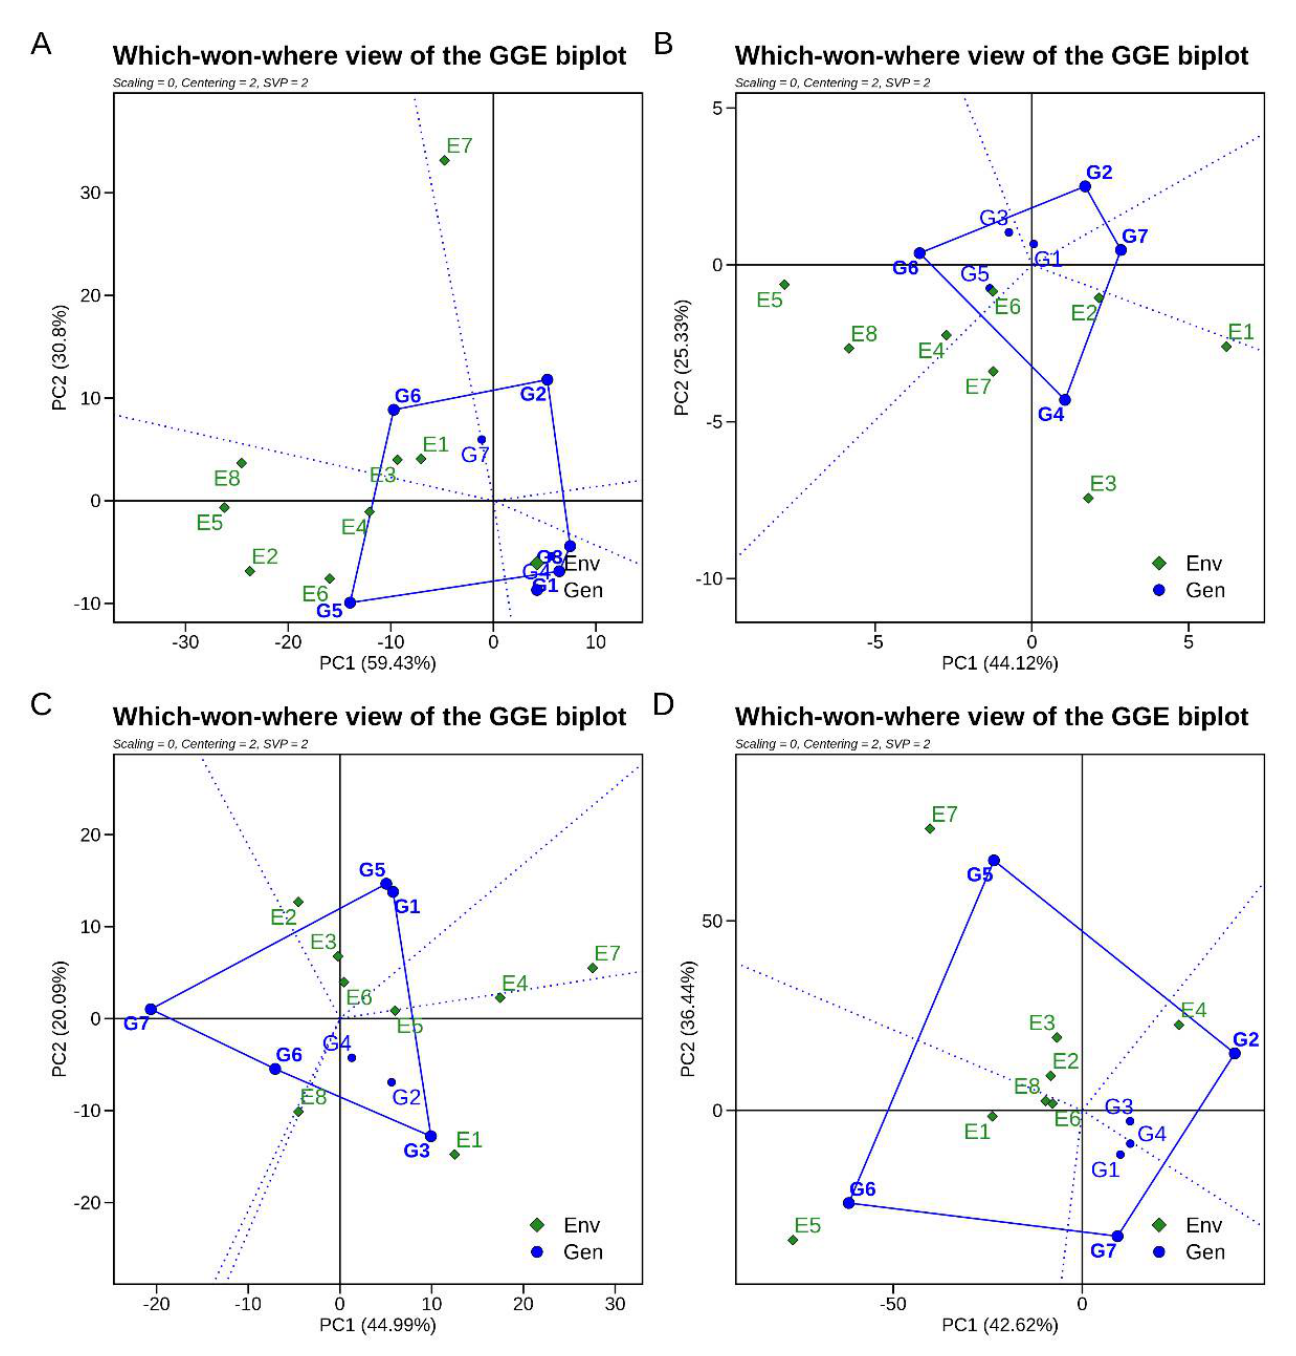
Figure 6. The GGE biplot polygon of the ‘Which-won-where’ pattern to identify the best cultivar in each location of 5 GSR lines and 2 control lines grown under eight environments year in 2021 for ( A ) plant height, ( B ) the number of tillers, ( C ) grain yield, and ( D ) straw yield. The biplots were created with centering = 0, SVP = 2, and scaling = 0 parameters.